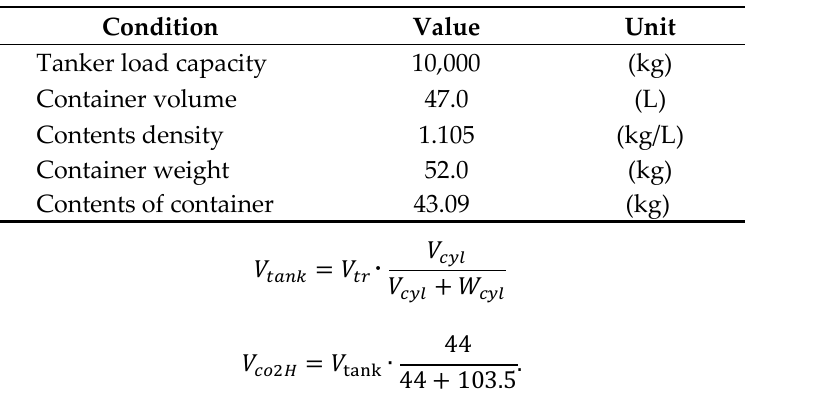
Table 5. Calculation condition of CO 2 hydrate load